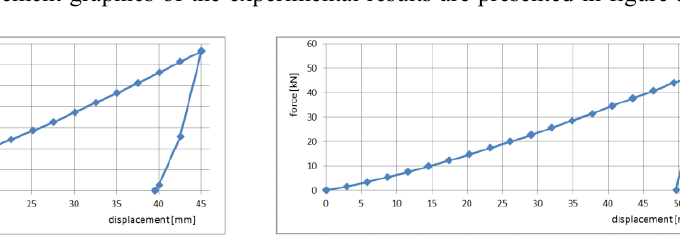
Fig.5 Force-displacement graphic - model 1 Fig.6 Force-displacement graphic - model 2